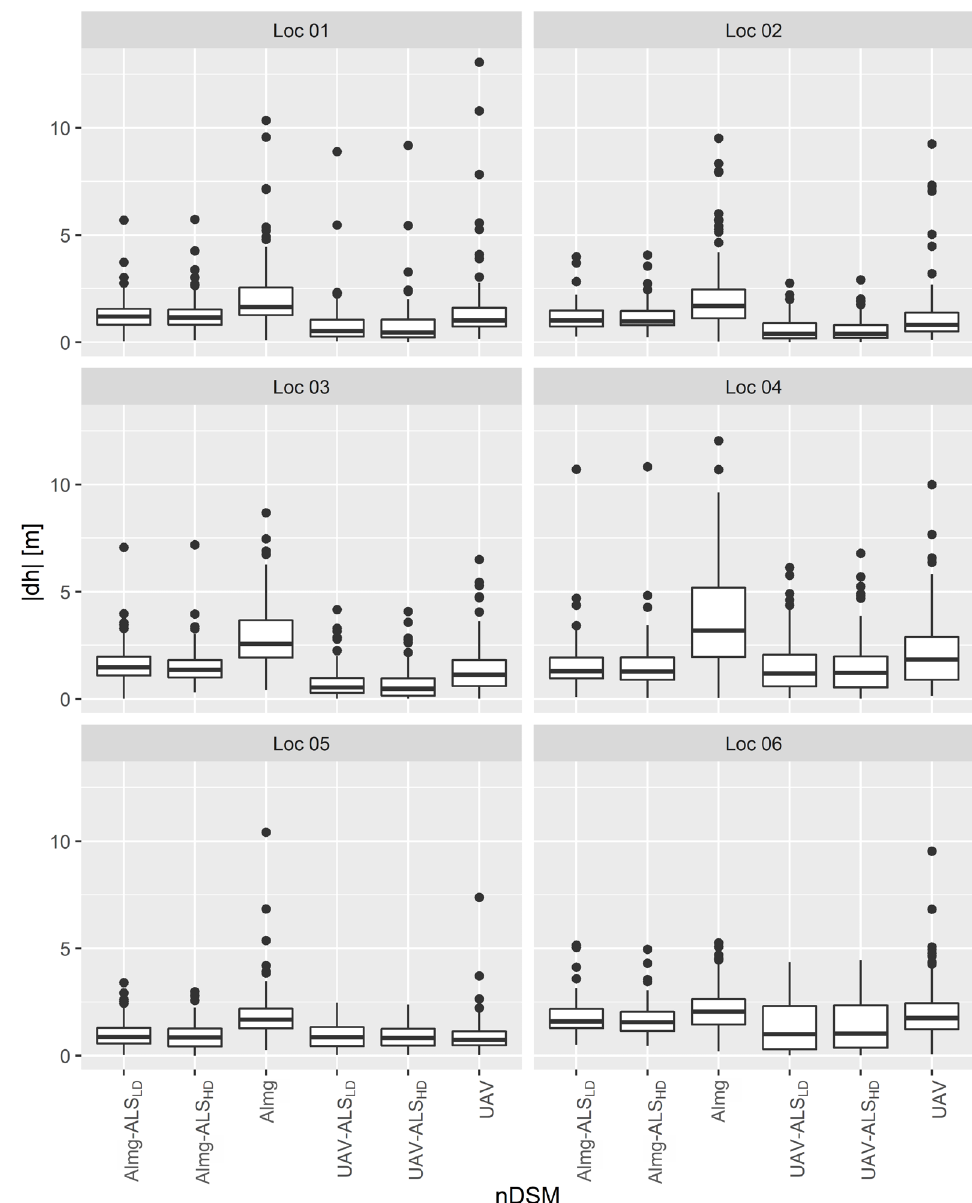
Figure A2. Box-plots displaying quartile characteristics (median, Q25, and Q75) of nDSM height differences for individual study locations. For each location, 100 randomly selected woody plant tops were used. Black dots represent outliers.